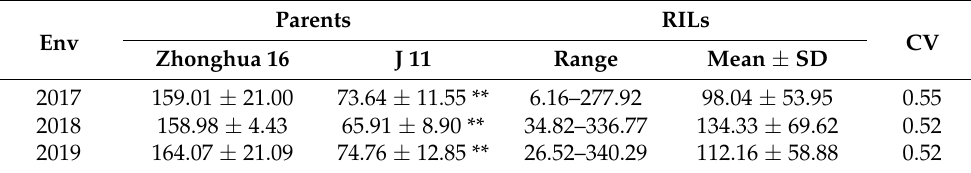
Table 1. The phenotypic variation of ATC in the RIL